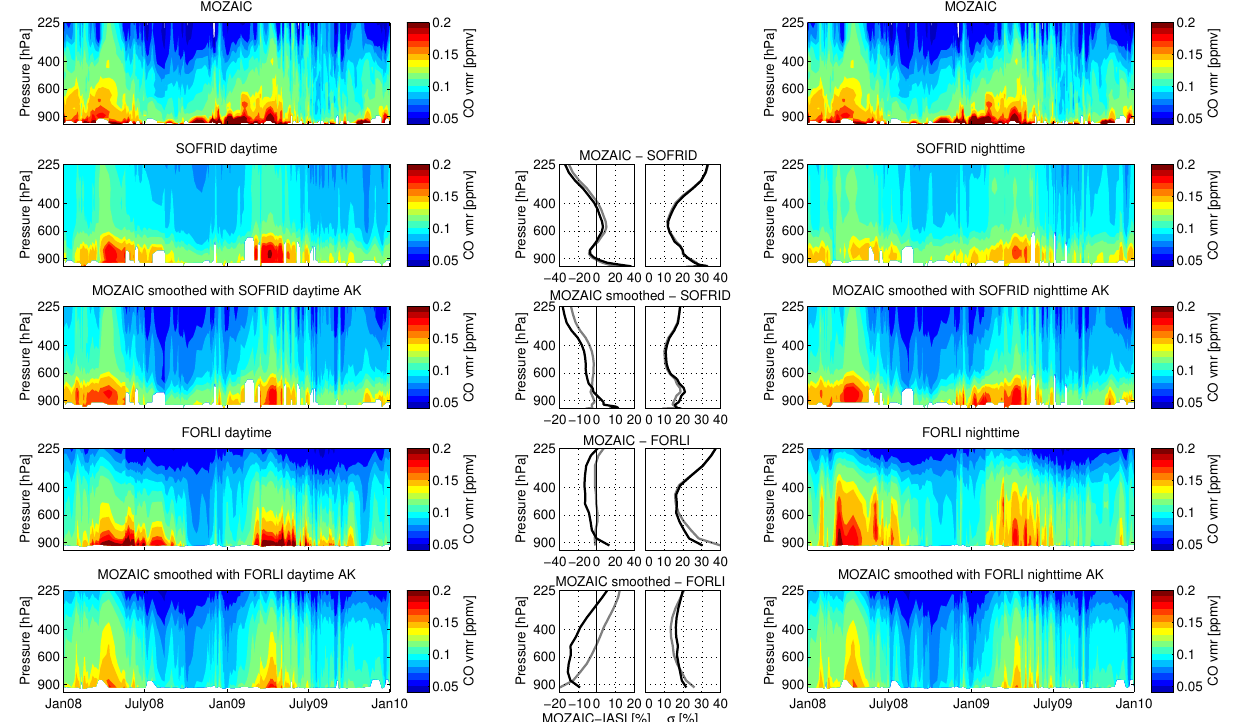
Fig. 7. Left panels: temporal variation of CO profiles at Frankfurt for the years 2008–2009, as observed by (from top to bottom panels) MOZAIC, daytime SOFRID, MOZAIC convolved with SOFRID daytime averaging kernels (AK), daytime FORLI and MOZAIC convolved with FORLI daytime AK. A 5-point moving average was applied. (middle) Normalised mean differences between MOZAIC and IASI profiles (MOZAIC-IASI/((MOZAIC+IASI)/2)) and standard deviation ( σ ), for daytime (grey) and nighttime (black) retrievals, in percentage. Right panels: as the 5 panels on the left, but for IASI nighttime retrievals. Note that the time series of the raw MOZAIC profiles at Frankfurt is presented twice (the top left and right panels are